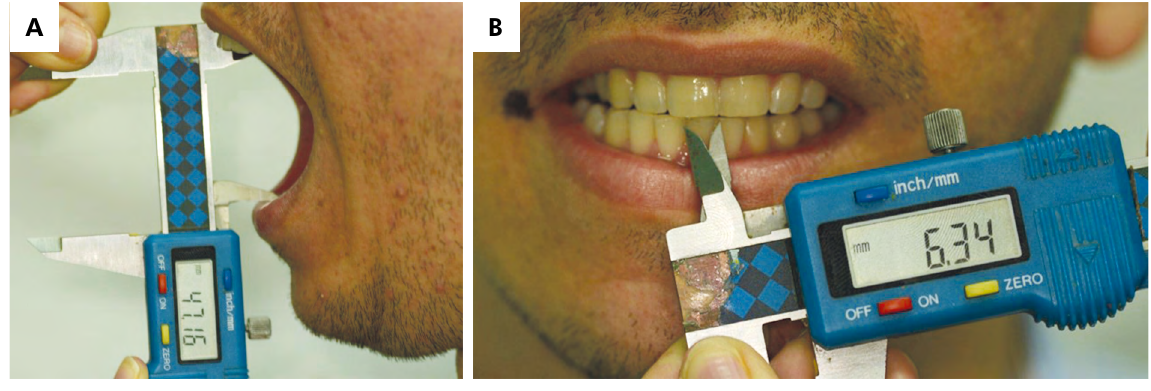
Figure 3. Mandibular movement measurements made with a standard caliper. A - Mouth opening. B - Lateral movement.